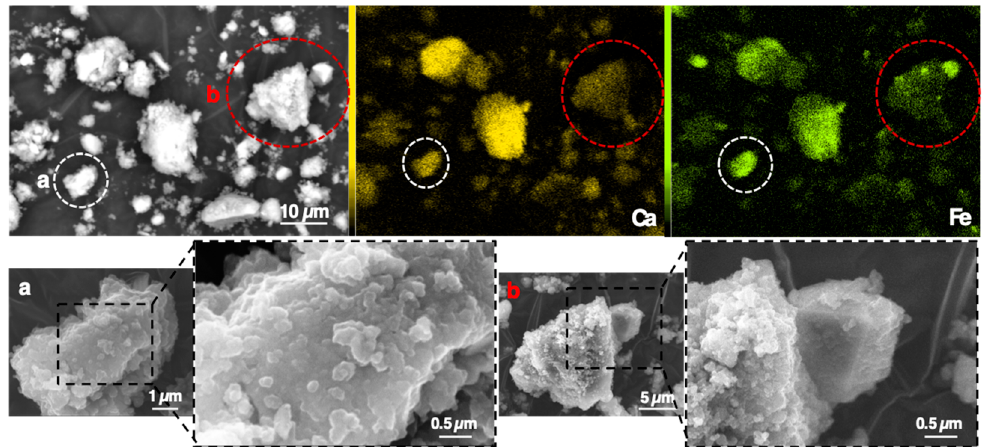
Figure 5. Backscattered scanning electron microscope (SEM) image of Huntly-GP catalyst with energy-dispersive spectrometer (EDS) maps for the Ca and Fe (top), and high magnification SEM of the circled spots ( a ) and ( b ) (bottom).